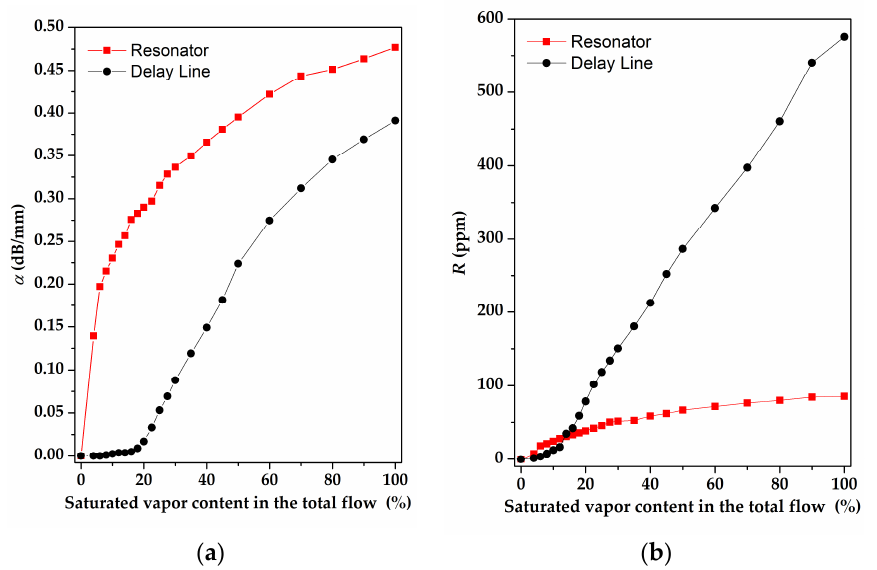
Figure 21. ( a ) The amplitude and ( b ) the phase responses of devices #1 with LB AA and #2 with LB SA-sensitive films consisting of 17 monolayers versus chloroform concentration.